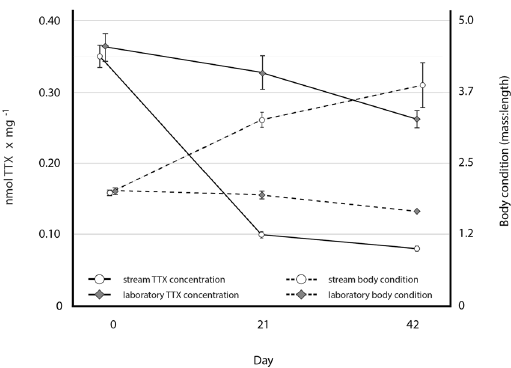
Figure 3. The TTX concentrations and body condition of larval siblings reared in two environments across time. At hatch (day 0), siblings showed nearly identical mean TTX concentrations and body condition. However, sibling responses differed through time between environments. In general, laboratory-reared larvae maintained greater TTX concentrations, but had lower body condition, whereas stream-reared siblings responded oppositely. The three-way interaction term between location (stream or laboratory), time, and body condition was significant ( P = 0.005), suggesting that there are trade-offs between larval body condition and chemical